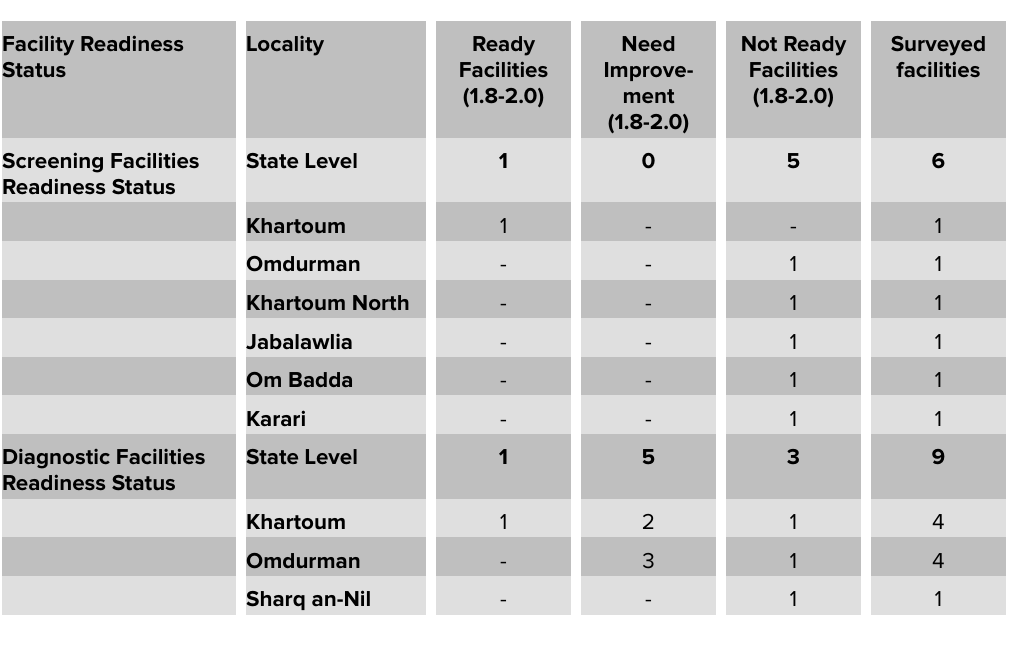
TABLE 3: The geographic distribution of cervical cancer centers in Khartoum state according to the facility readiness